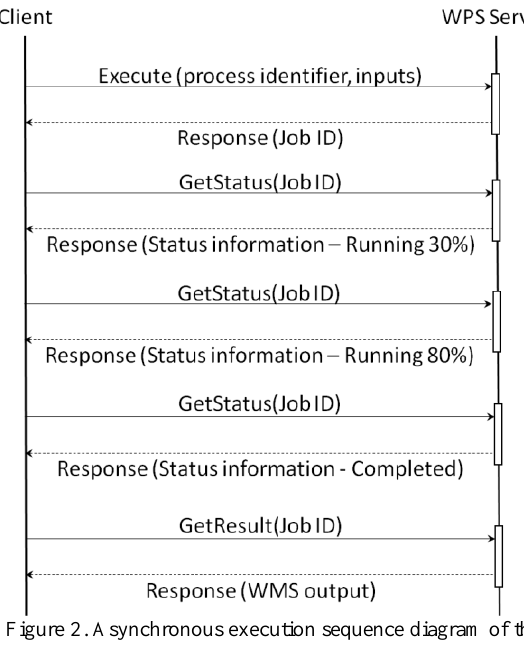
Figure 2. Asynchronous execution sequence diagram of the WPS